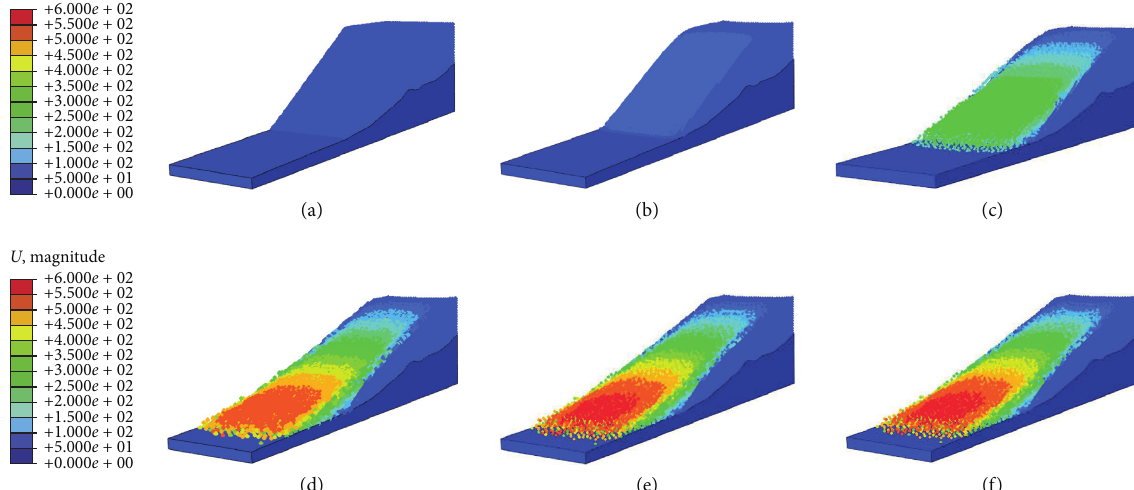
Figure 12: The displacement (U magnitude) and shapes of the landslides at different times. (a) t � 0 s. (b) t � 8 s. (c) t � 17 s. (d) t � 30 s. (e) t � 40 s. (f) t � 100 s.